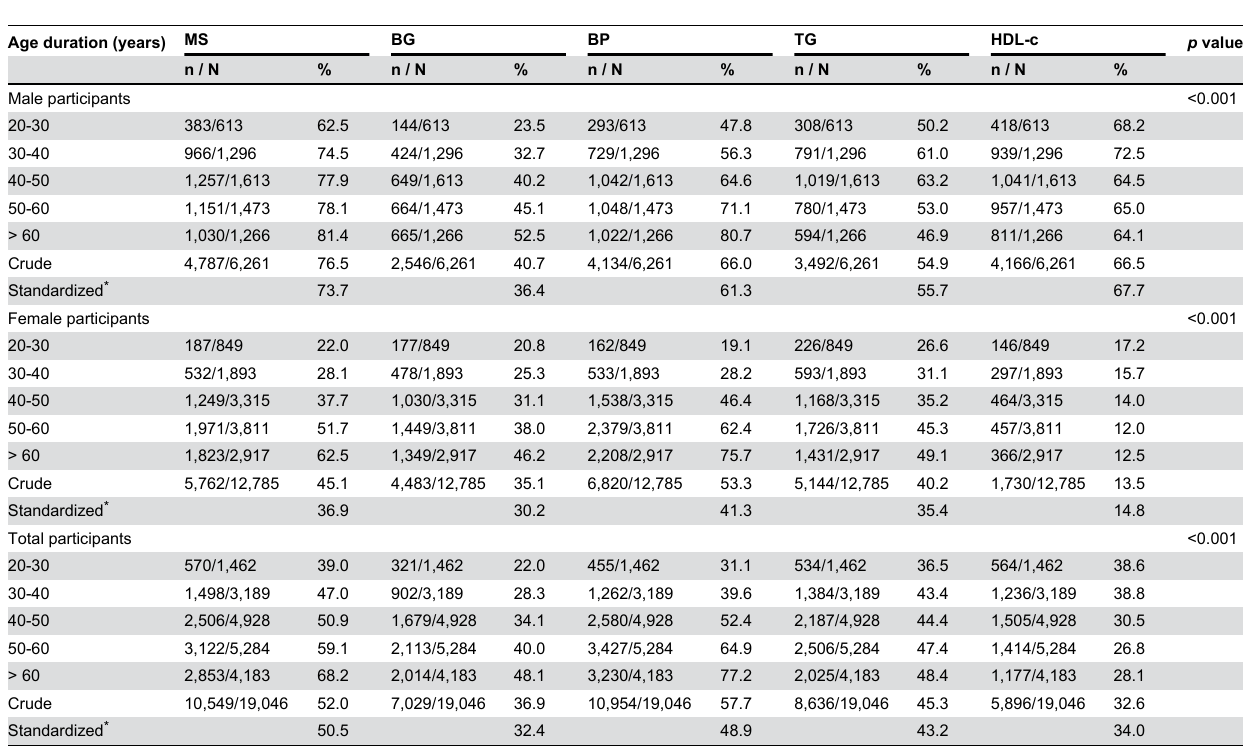
Table 2. Age-standardized prevalence of MS and its components in male, female and total participants with abdominal